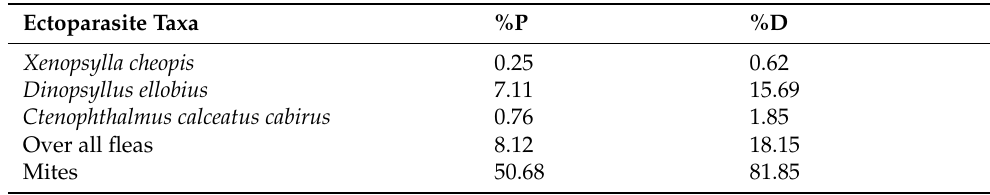
Figure 4. Ectoparasite infestation on M. delectorum and R. dilectus : ( a ) prevalence (%) between host sexes; ( b ) flea mean abundance with SE bar; ( c ) mite mean abundance with SE bar. Table 2. Flea and mite infestation probability (%P) and ecological dominance index (%D) on M. delectorum and R. dilectus rodents .